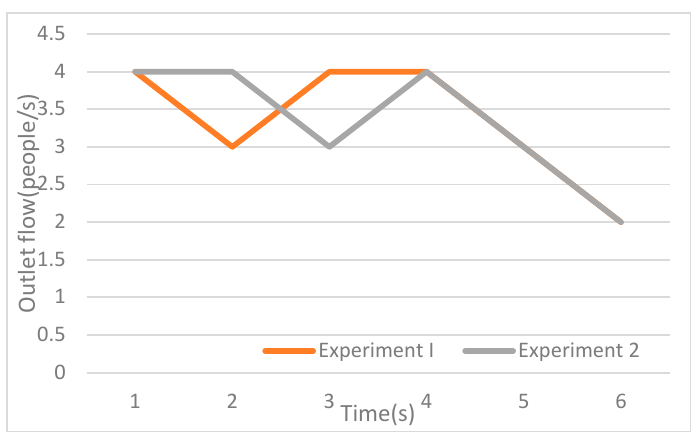
Figure 29. Line chart of outlet flow.